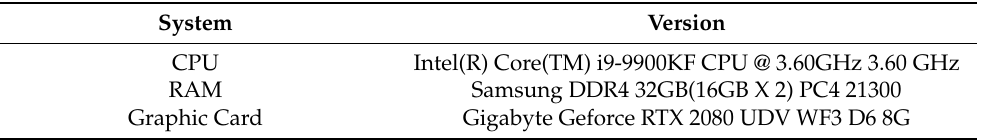
Table 1. System Environment.